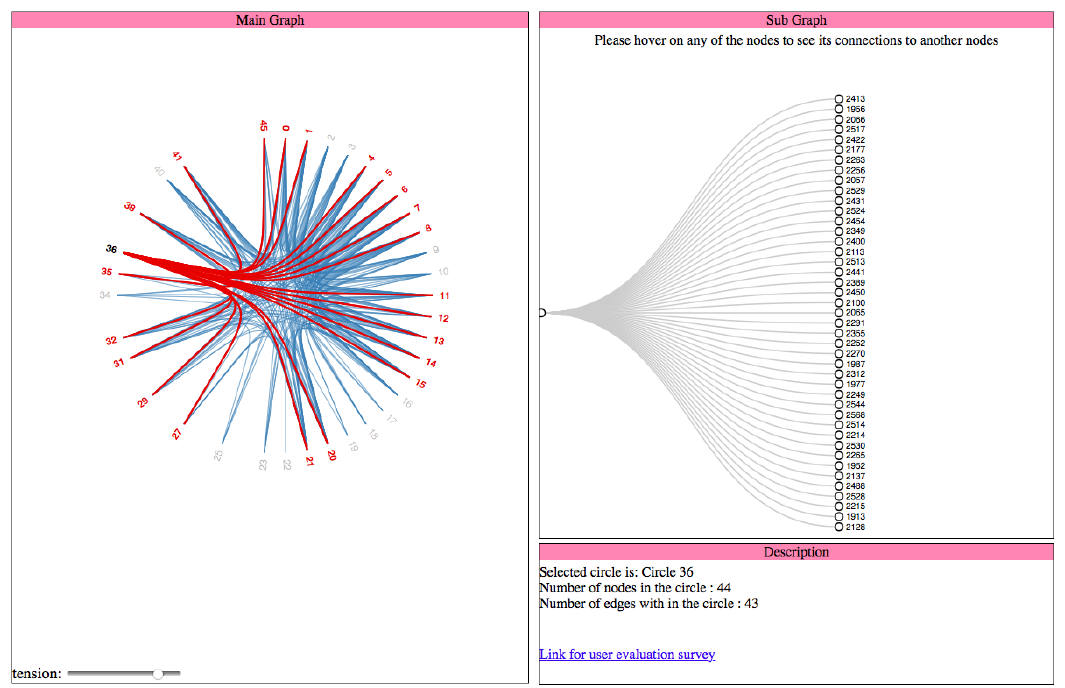
Figure 9. User interface for visualization using hierarchical edge bundling for the main graph and cluster dendrogram for the sub